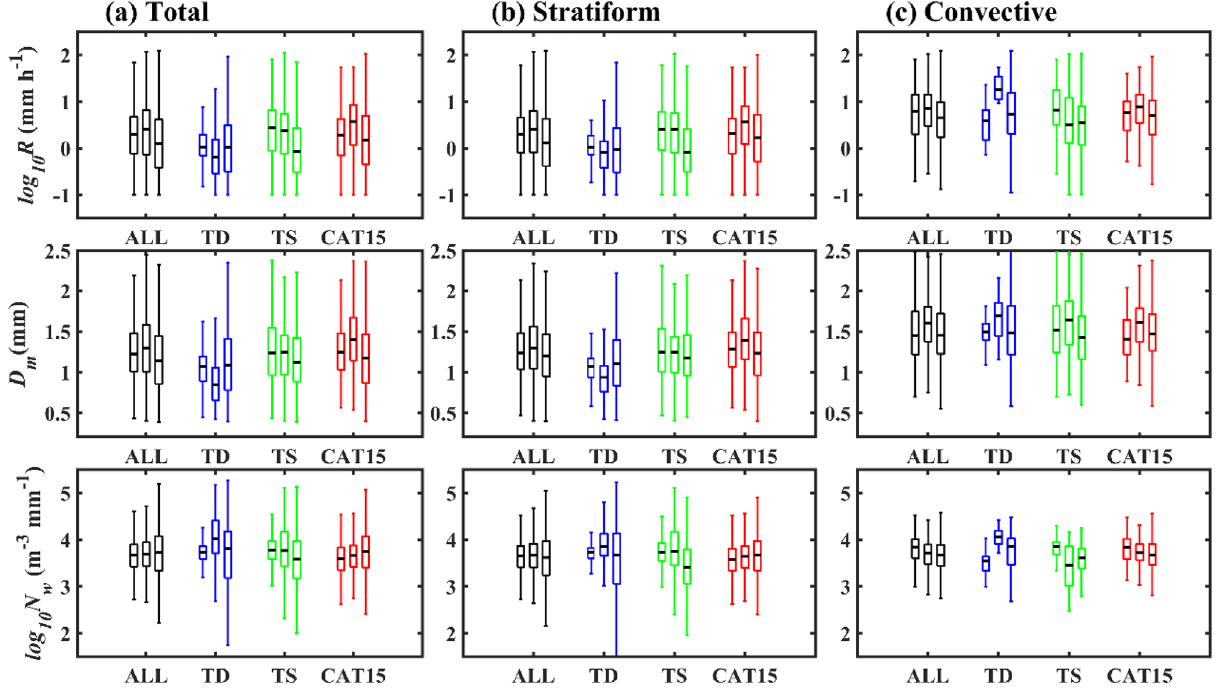
Figure 5. Variations in RSD parameters in different rain regions (IC: inner core, IB: inner rainbands, and OB: outer rainbands) of TCs. Distribution of rainfall rate (log 10 R , R is in mm h –1 ) ( first row), mass-weighted mean diameter ( D m , mm) (second row), normalized intercept parameter (log 10 N w , N w is in m –3 mm –1 ) (third row) for ( a ) total ( b ) stratiform ( c ) convective precipitation for TCs of all category, TDs, TSs, and CAT15. Three boxplots in each TCs category denote the IC, IB and OB, respectively from left to